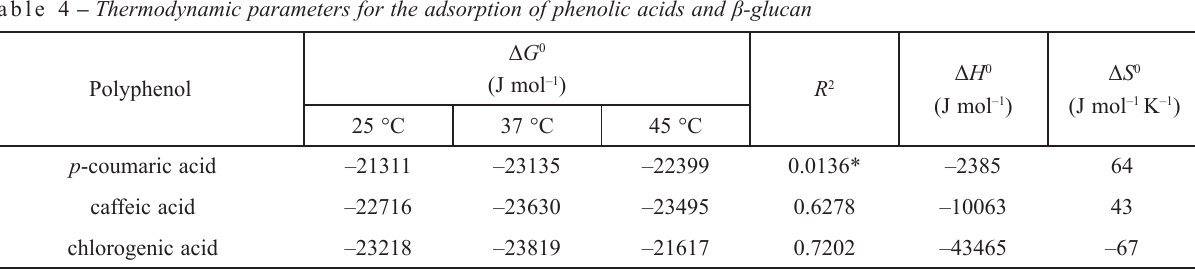
*in these cases, the data were inconsistent with a linear